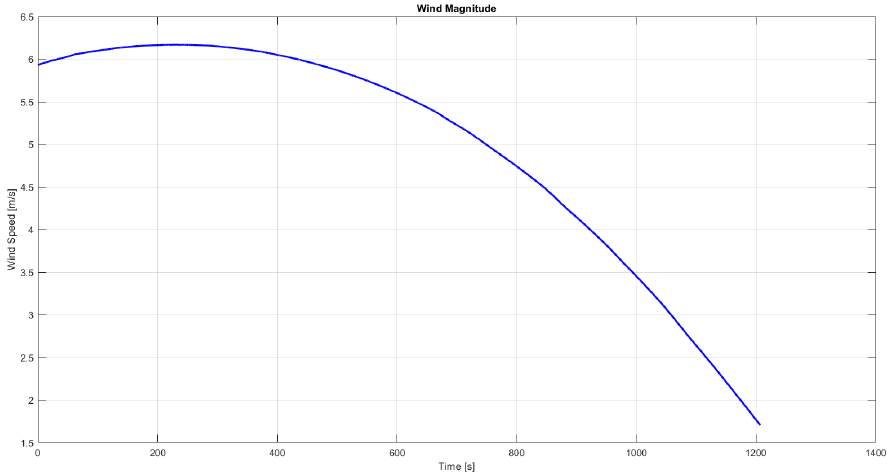
Figure 23. Wind profile used during the simulation in Figures 21 and